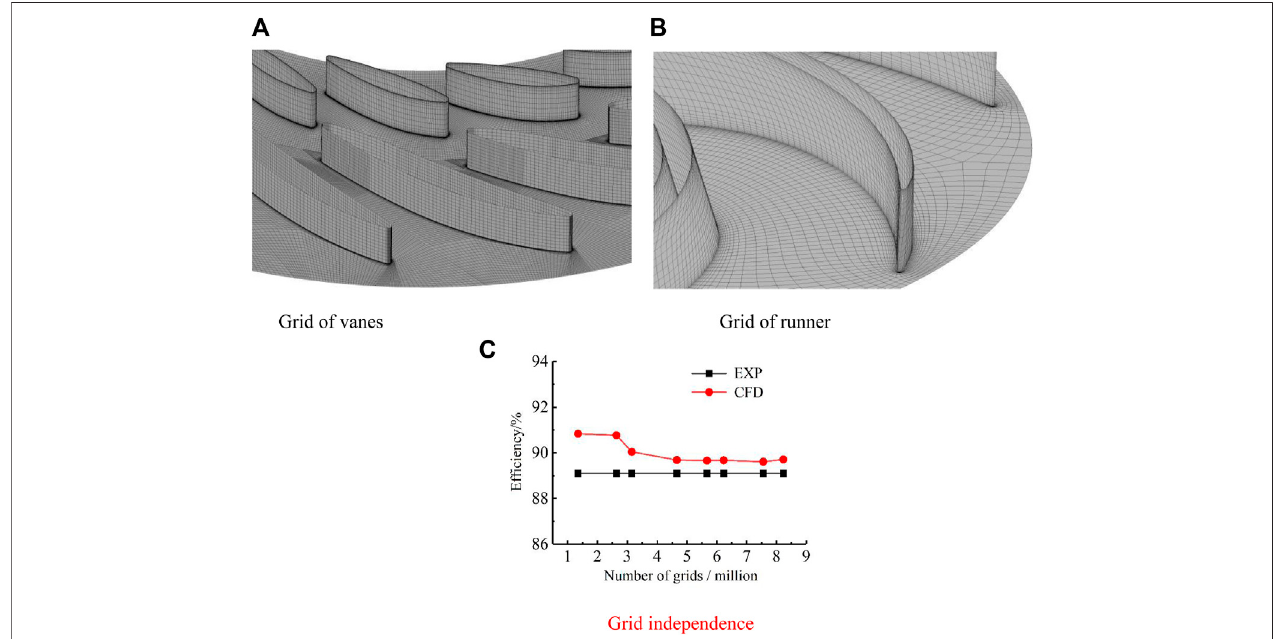
FIGURE 2 | Grids and grid independence. (A) Grid of vanes (B) Grid of runner (C) Grid independence.